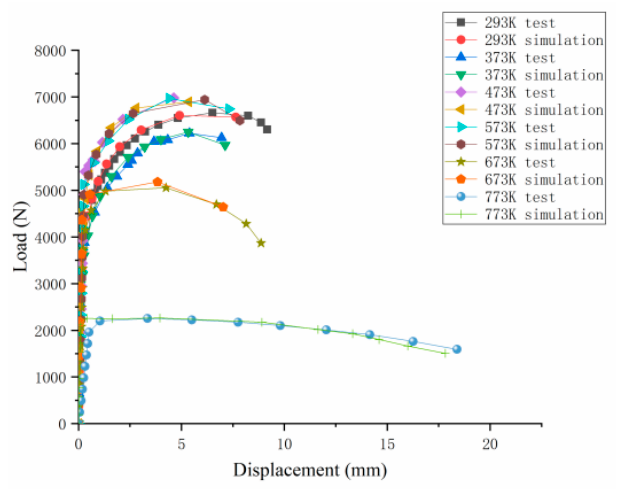
Figure 8. Comparison curve of uniaxial tensile load and